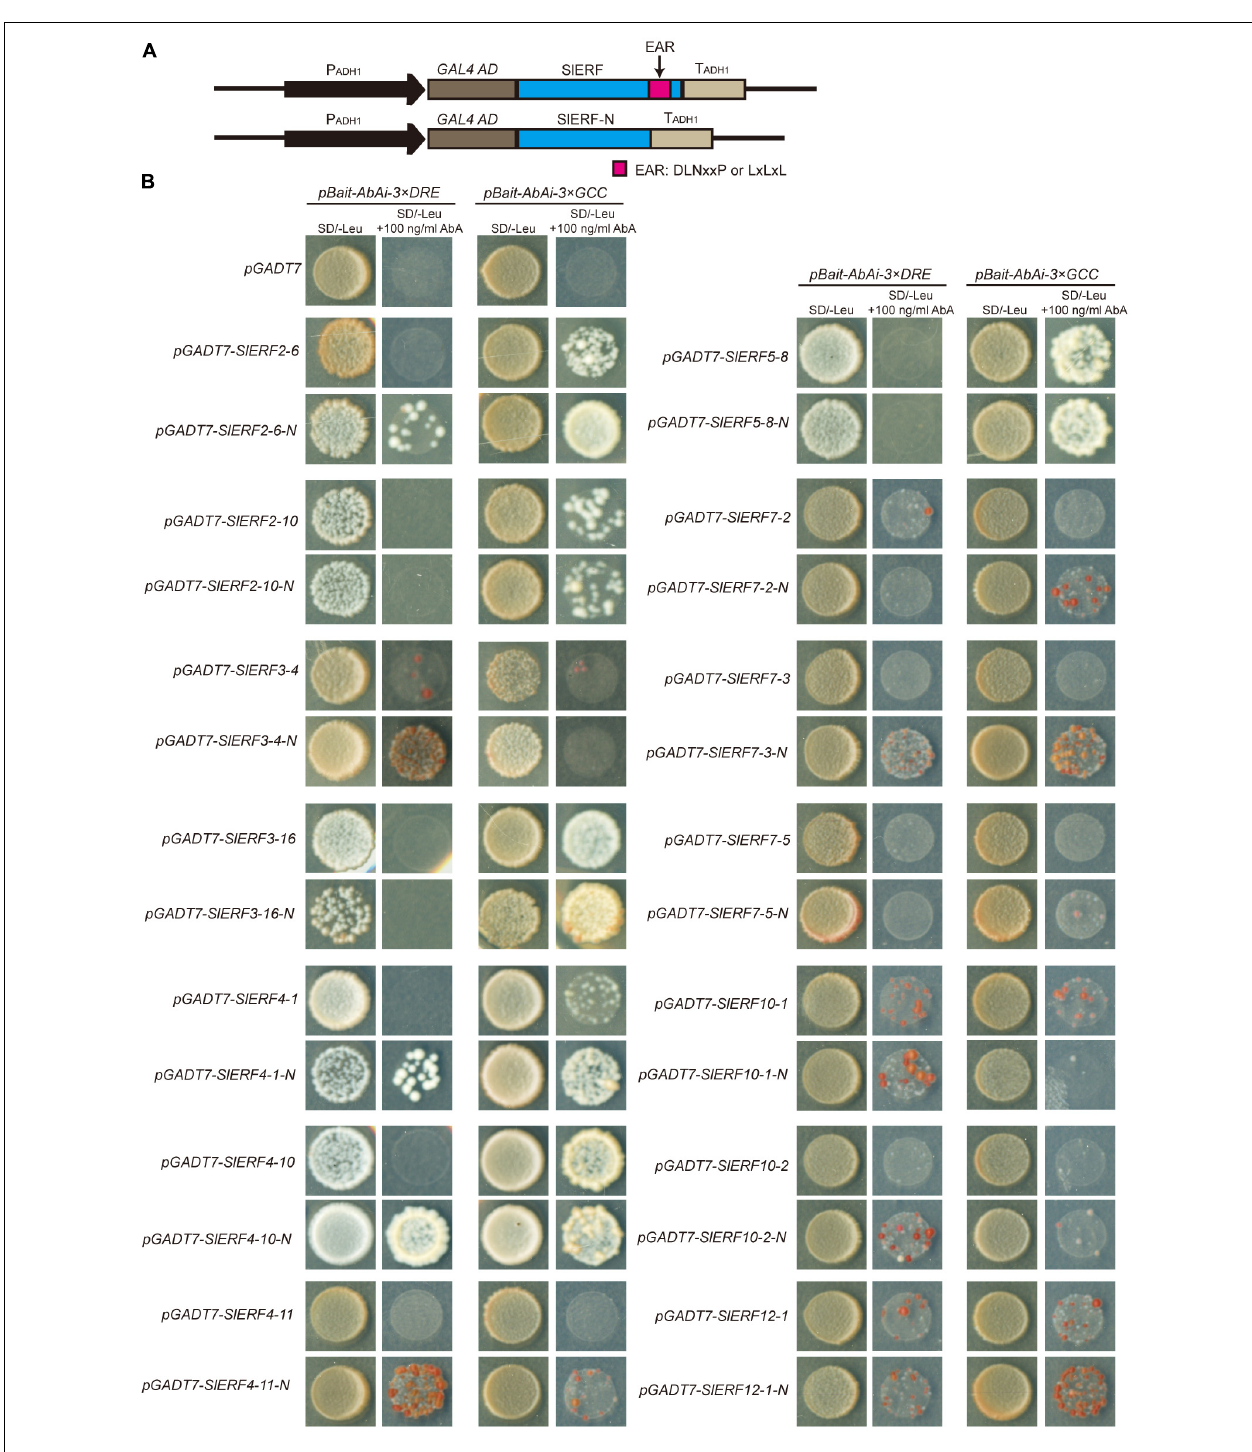
FIGURE 6 | The repressing function analysis of the EAR motif in SlERF proteins by a Y1H assay. (A) Construction of the Y1H recombinant vectors. (B) The activation ability analysis of 14 SlERF proteins retained or deleted EAR motifs in a Y1H assay.